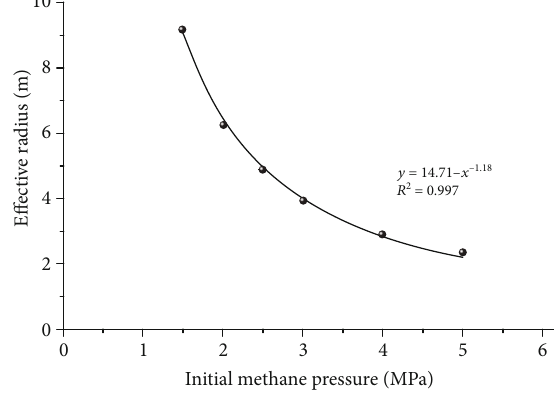
Figure 13: Relationship between methane pressure and e ff ective